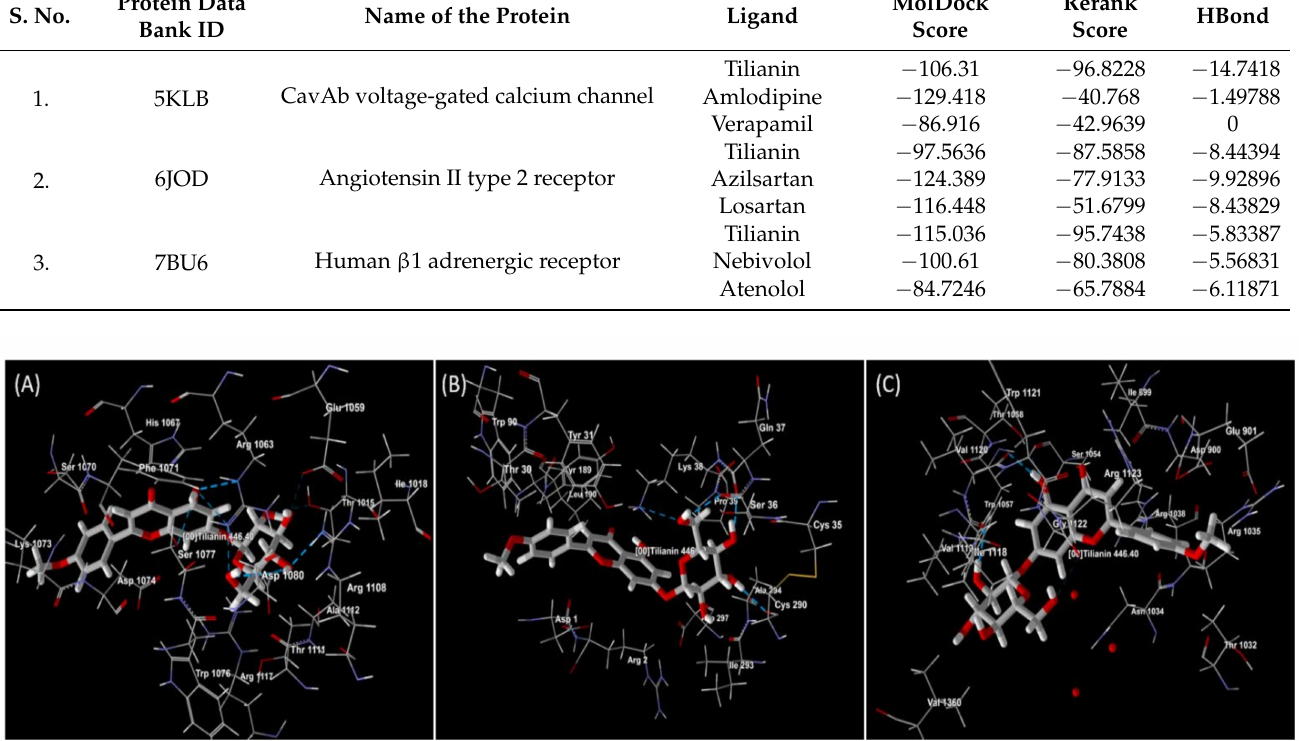
Figure 7. Docked view of Tilianin on ( A ) PDB ID: 5KLB (CavAb voltage-gated calcium channel), ( B ) PDB ID: 6JOD (Angiotensin II type 2 receptor) and ( C ) PDB ID: 7BU6 (Human beta-1 adrener- gic